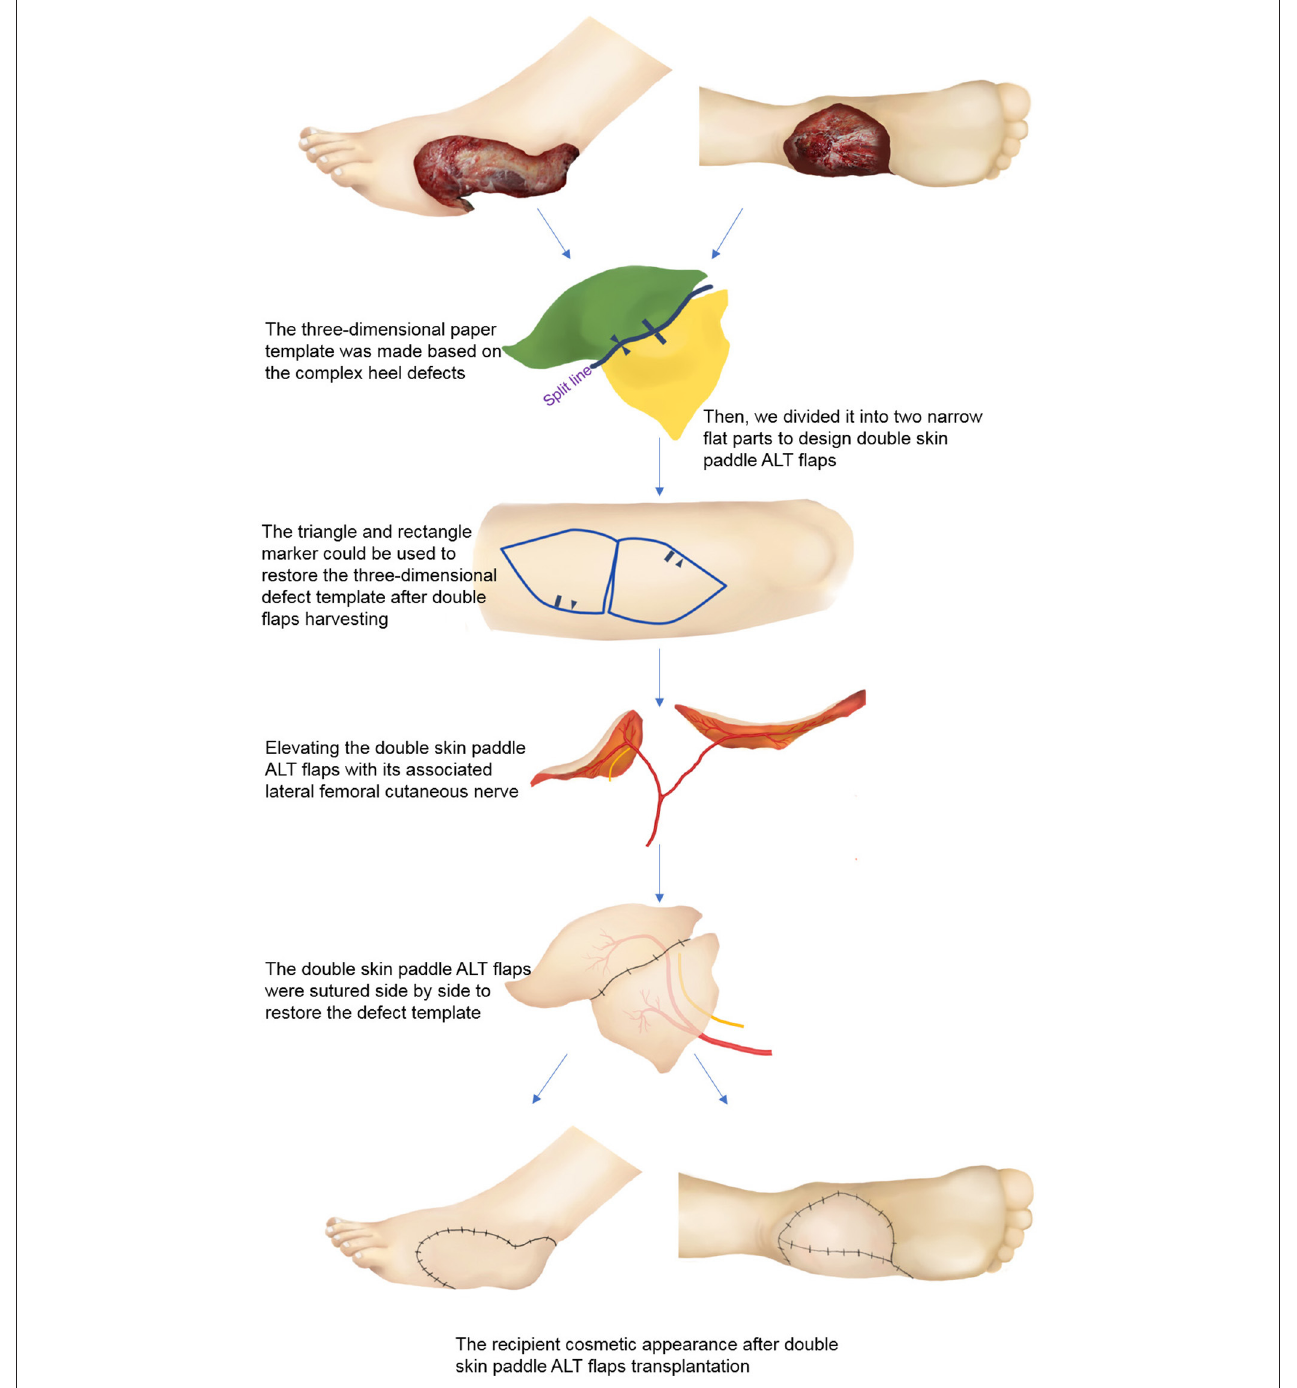
FIGURE 1 | Schematic diagram of double skin paddle ALT flaps for complex heel defects. ALT, anterolateral thigh perforator.